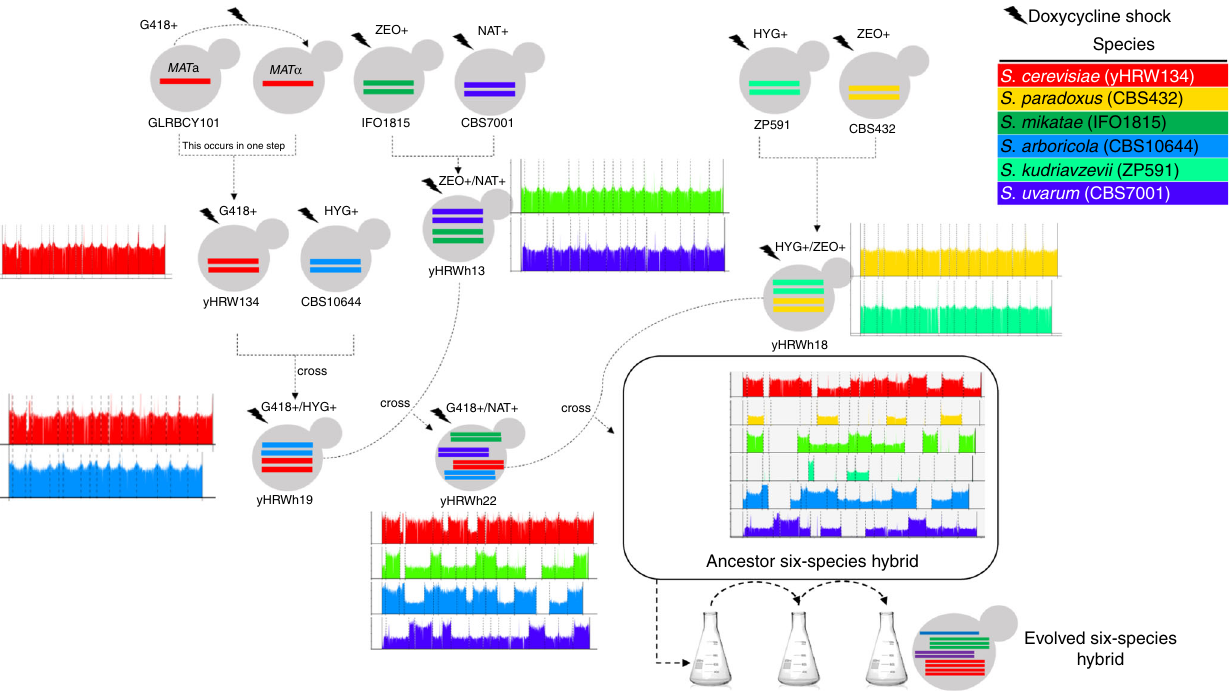
Fig. 1 The generation of ancestor and evolved six-species hybrids. Synthetic hybrid generation scheme using the iHyPr method. The example shown is the six-species hybrid yHRWh39. Chromosomes were colored according to their species designation, with height representing copy number, using the sppIDer pipeline 48 . For an extended explanation of iHyPr, including the other two crossing schemes, see Supplementary Figs. 1 and 2. Arrows mark hybridization steps. For additional intermediate and six-species hybrid nuclear and mitochondrial genomes with higher resolution, see Supplementary Figs. 3 and 4. Ancestor six-species hybrids underwent ALE for 80